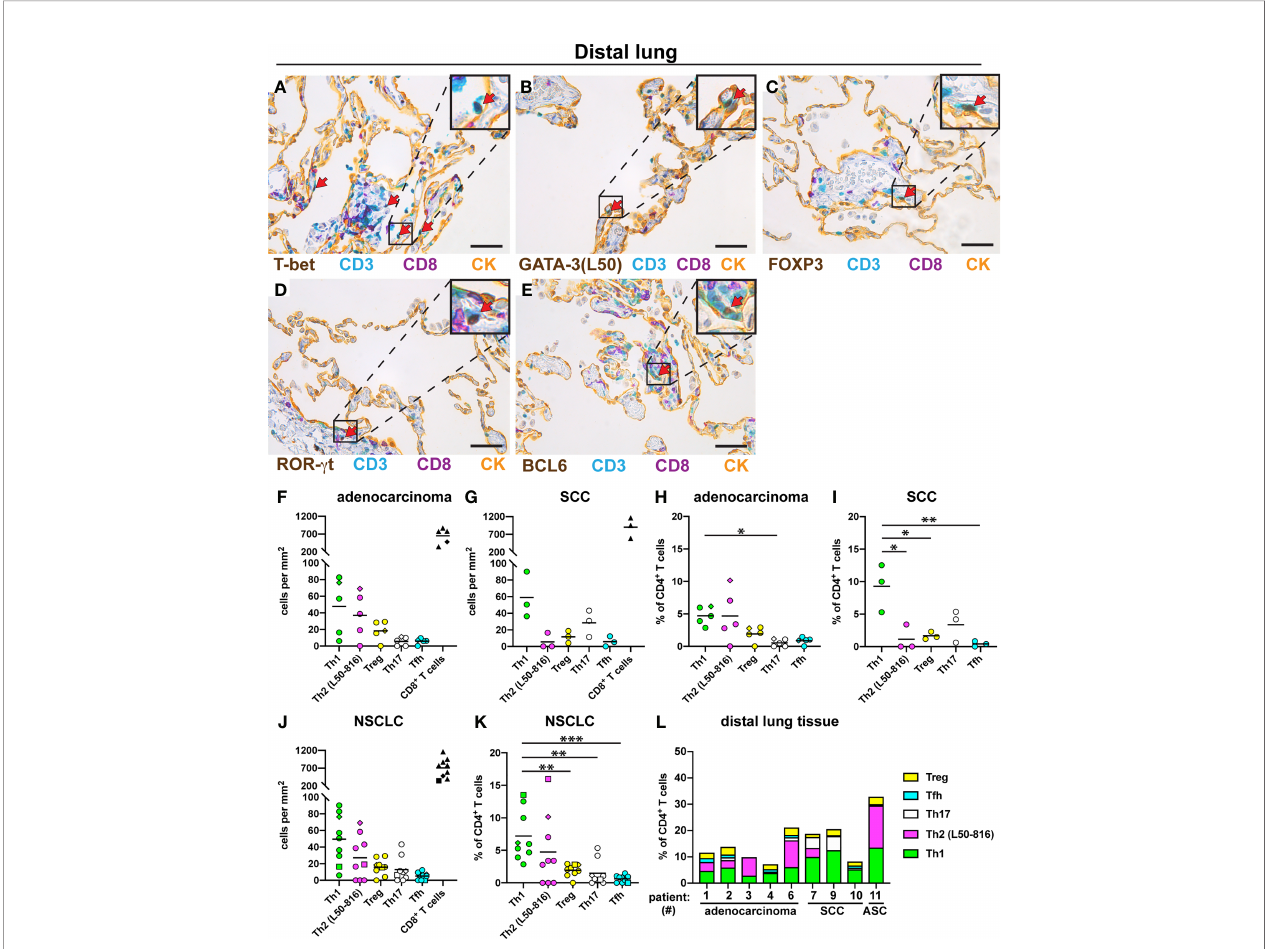
FIGURE 5 | Quanti fi cation of Th cell subsets and CD8 + T cells in distal lung. Non-cancerous distal lung tissue was sampled furthest away from the tumor in the resected lobe from 9 NSCLC patients [5 adenocarcinoma, 3 squamous cell carcinoma (SCC), and 1 adenosquamous carcinoma (ASC)]. Serial sections were immunostained and cells were quanti fi ed. (A – E) Representative images of stained Th cells in distal lung. A pan-cytokeratin (CK) stain was used to visualize the alveolar epithelial cells (yellow). Boxed areas are enlarged and shown as corner insets. Positive cells for each Th subset are indicated by red arrows. (A) Th1 cells (T-bet + CD3 + CD8 - ). (B) Th2 cells (GATA-3 + CD3 + CD8 - ) identi fi ed with anti-GATA-3 mAb clone L50-816 (L50). (C) Treg cells (FOXP3 + CD3 + CD8 - ). (D) Th17 cells (ROR- g t + CD3 + CD8 - ). (E) Tfh cells (BCL6 + CD3 + CD8 - ). (F – L) Quantitative data for T cell subsets in distal lung. (F) Number of cells per mm 2 in distal lung of adenocarcinoma, or (G) SCC. (H) Percentage of each Th subset (of all CD3 + CD8 - Th cells) in distal lung of adenocarcinoma, or (I) SCC. (J) Pooled cell density data in distal lung for all NSCLC patients. (K) Pooled NSCLC data for Th percentages in distal lung. (L) Th subset composition in distal lung (as percent of all CD3 + CD8 - cells) for each patient. Each symbol in the graphs represents one patient and black lines indicate mean values. The square symbol indicates the adenosquamous carcinoma patient. The rhombus symbol indicates the never-smoker patient. Statistical analysis was performed using one-way ANOVA with Bonferroni´s post-hoc test. *p<0.05, **p<0.01, ***<0.001. Original magni fi cation, 400x. Scale bars, 50 m